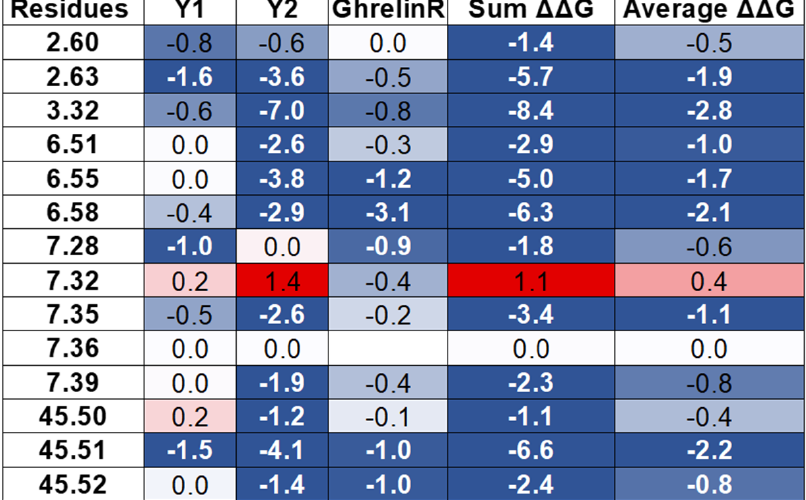
Figure 8. Models of peptide/class A GPCR complexes show that the peptides interact with the top 14 common residues. (From left to right ): A table lists the ΔΔ Gs values of the 14 common residues of Y1 [56], Y2 [14], and ghrelin receptors [72], as well as their sum and average values. The absence of the ΔΔ G values indicates that the corresponding residues do not interact with the peptide ligands. The residue ΔΔ G cells are colored based on the ΔΔ G values (negative: Blue, neutral: White, and positive: Red). The blank cells indicate that the residues do not interact with the peptide ligands. Models of NPY (cyan) bind with the Y1 receptor (grey) and the Y2 receptor (orange), and ghrelin (magenta) binds with the ghrelin receptor (green). A GPCR pharmacogenomics study has extracted polymorphism data for the coding- region of the 108 GPCR drug targets [74]. From the data provided by the authors, we found around 30 relevant GPCR mutants that were predicted to be deleterious by the sort- ing intolerant from tolerant (SIFT) [75] or Polyphen [76]. Those 30 genetic invariants have population allele frequencies of around 1 to 28 over 120,000 individuals and are related to the shared peptide interacting residues or are close to those residues. The table containing the information regarding the relevant mutants of peptide and protein binding class A GPCRs is summarized in the supplementary table Peptide_binding_pocket_genetic_vari- ants.xlsx. The data suggest the great potential of the proposed common peptide-binding pocket as drug targets for class A GPCRs. 3. Structural Changes in Peptides Induced by Receptors Are Critical for Binding This theme of conformational change in peptides in their bound state is not unique to peptide-GPCR recognition. Studies of ubiquitin by X-ray crystallography bound to var- ious substrates identified several unique conformations. However, the NMR analysis re- vealed that all of these conformations existed simultaneously in the solution, demonstrat- ing that the conformational selection drove the binding recognition event [77]. Peptide binding sites have been characterized to require unique conformations of peptide ligands